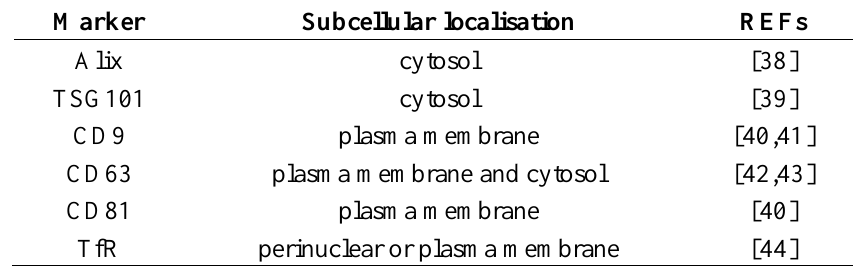
Table 1. Currently accepted exosomal protein markers and their common subcellular